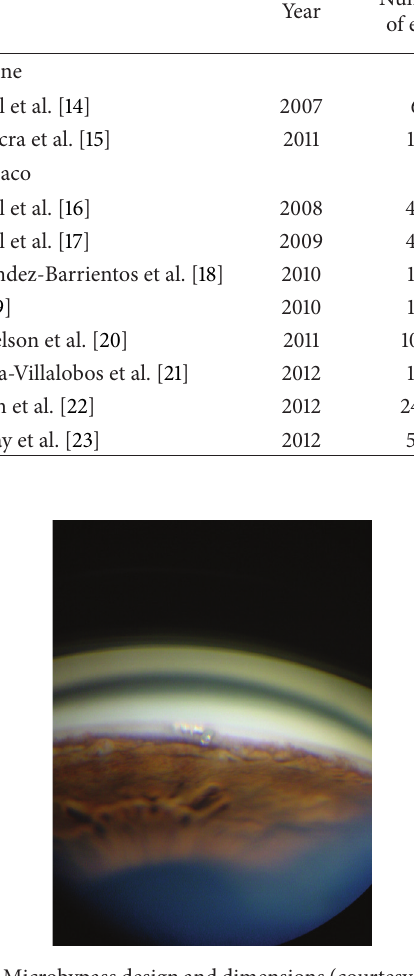
Figure 5: Microbypass design and dimensions (courtesy of Glaukos